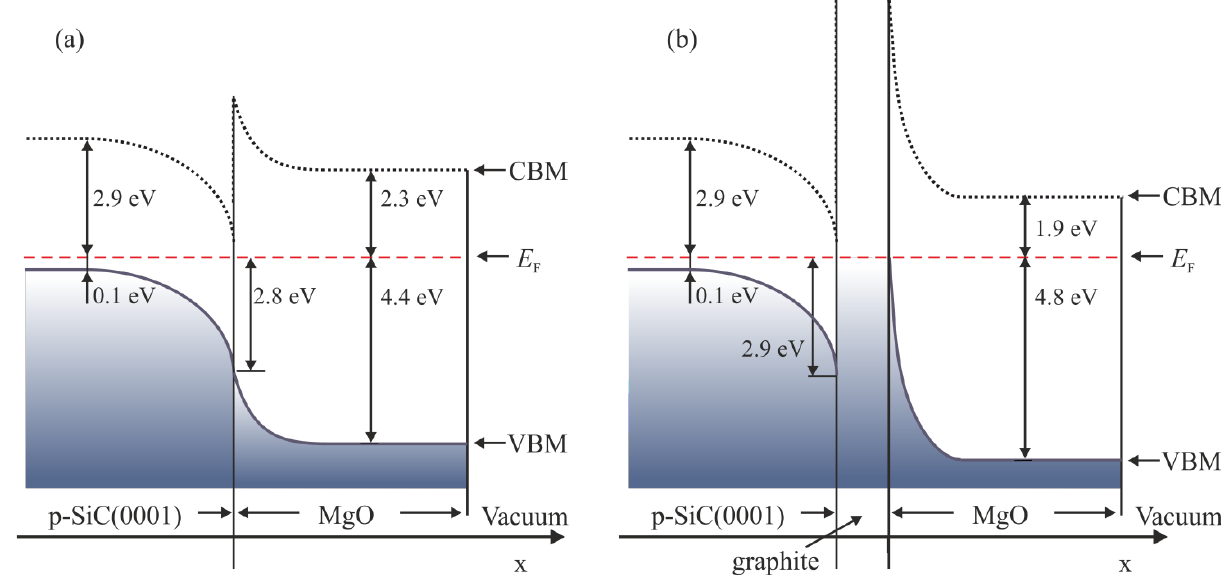
Figure 8. Illustrative energy level diagrams for ( a ) MgO/SiC and ( b ) MgO/graphite/SiC systems based on UPS measurements. In the sketches, the calculated depleted layer width is about 600 nm, and the highest thickness of MgO adlayers is 5 nm. The graphite interlayer is 3 nm thick.